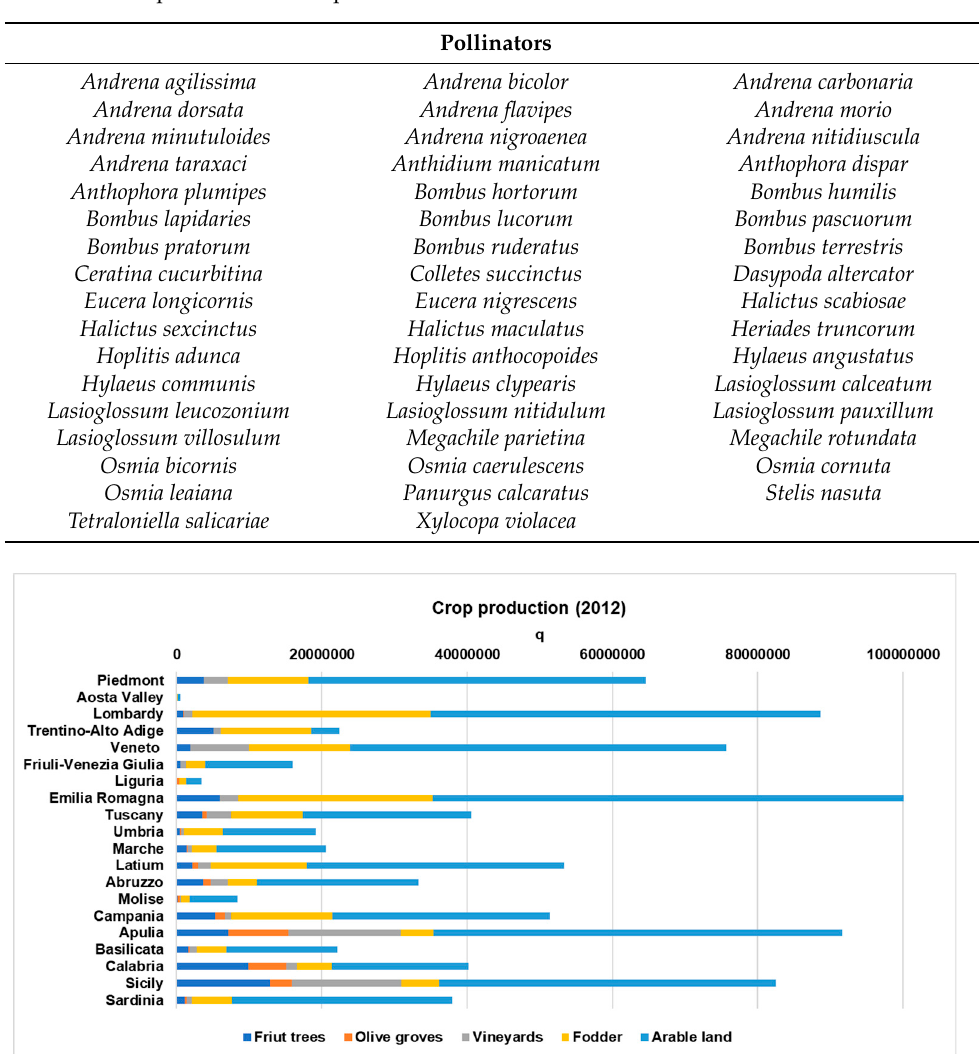
Table 3. Main species of selected pollinators.